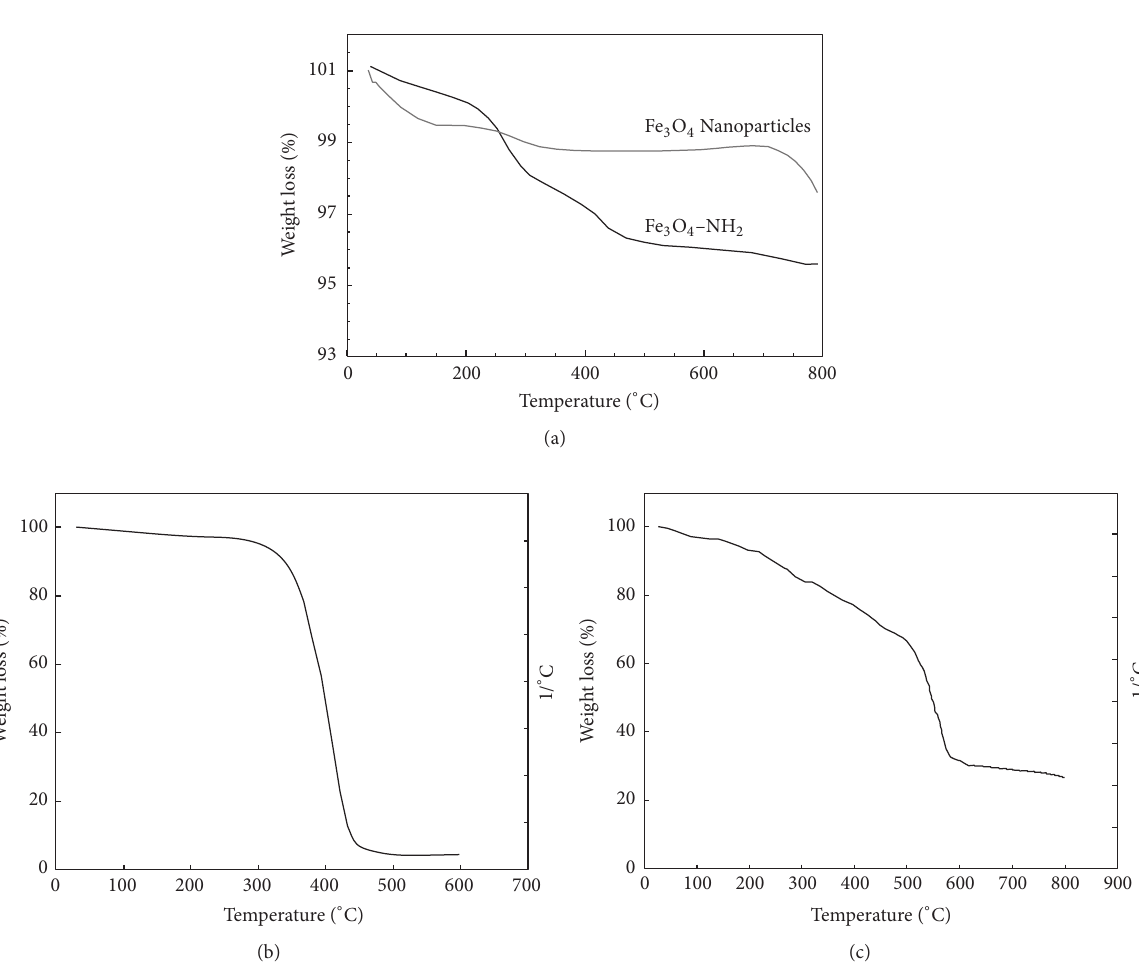
Figure 7: TGA thermograms of (a) bare Fe 3 O 4 nanoparticles and MNPs-NH 2 , (b) PGMA-MAn copolymer, and (c) PGMA-MAn/ ABSAc@Fe 3 O 4